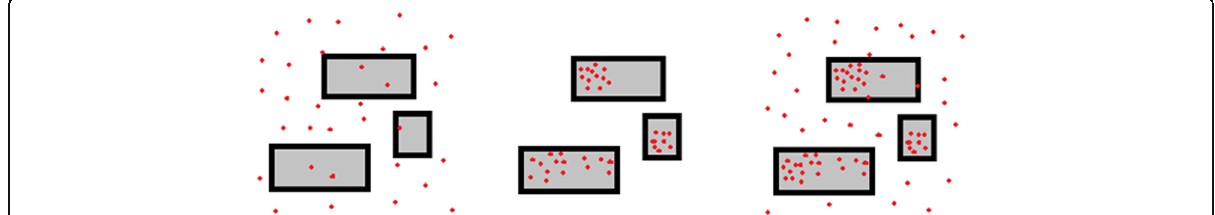
Fig. 8 Survivor distribution patterns. Gray boxes are buildings, red dots are survivors. From left to right: random, congregated, mixed